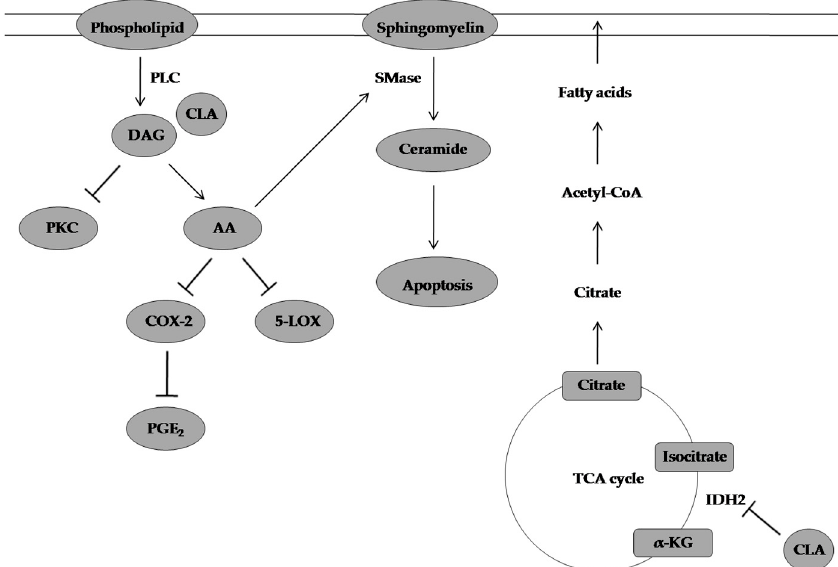
Figure 7. CLA-inducing apoptosis in prostate cancer cell lines by inhibiting DAG production, increasing AA and ceramide production, and inhibiting IDH2 activity. PLC: phospholipase C, CLA: conjugated linoleic acid, DAG: diacylglycerol, PKC: protein kinase C, AA: arachidonic acid, COX-2: cyclooxygenase-2, 5-LOX: 5-lipooxygenase, PGE2: prostaglandin E2, SMase:sphingomyelinase, α -KG: alpha-ketoglutarate, IDH2: isocitrate dehydrogenase.